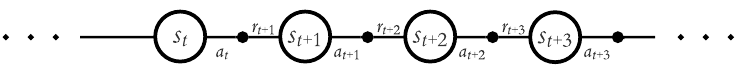
Figure 4. A SARSA algorithm sequence.